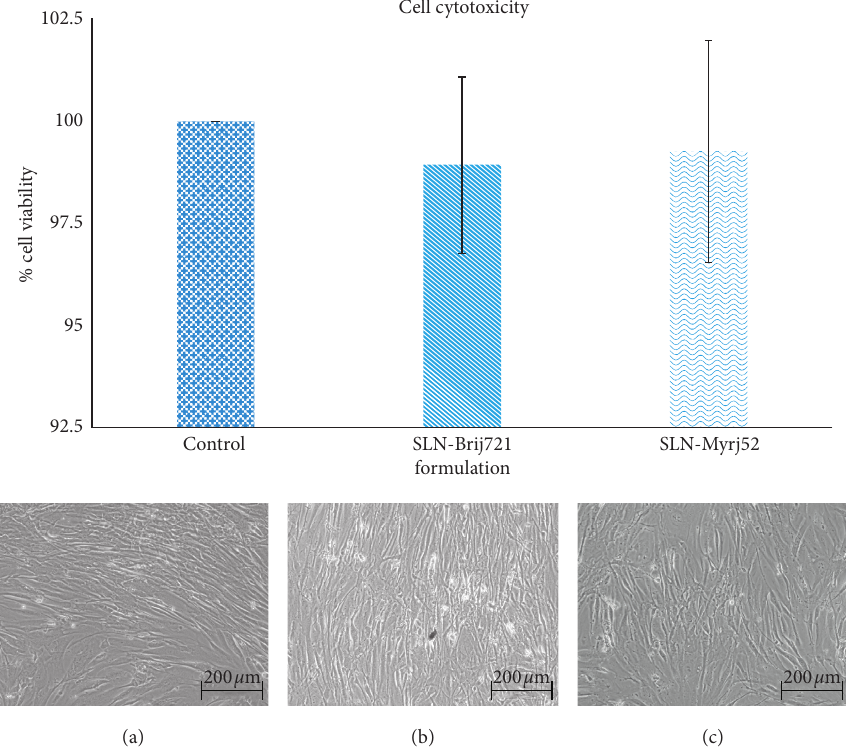
Figure 8: Cell cytotoxicity. (a) Control, (b) blank SLN from Brij 721, and (c) blank SLN from Myrj